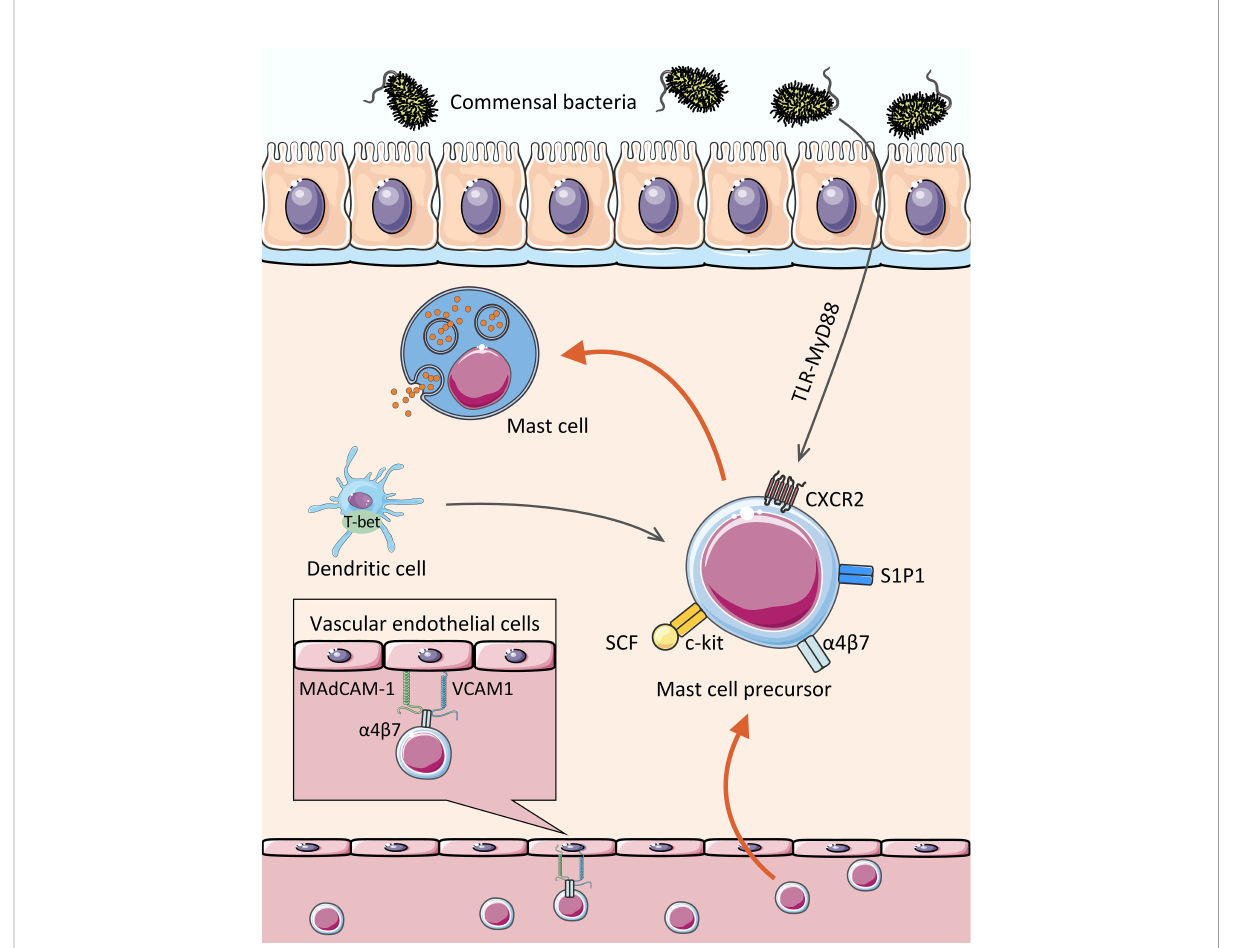
FIGURE 1 Assembly of MCs in the gut. The MCPs leave the hematopoietic tissue, enter the blood stream, migrate and colonize the target tissue. With c- kit, CXCR2, and integrin a 4 b 7 on the cell surface, MCPs bind to MAdCAM-1 and VCAM1 on the vascular endothelial cells, thereby crossing the vascular endothelium and colonizing the intestinal mucosa and submucosa, where they mature. In addition, transcription factor (dendritic cell- derived T-bet), Lipid mediator (sphingosine 1-phosphate), and some intestinal microbiota affect the homing of MCs to the